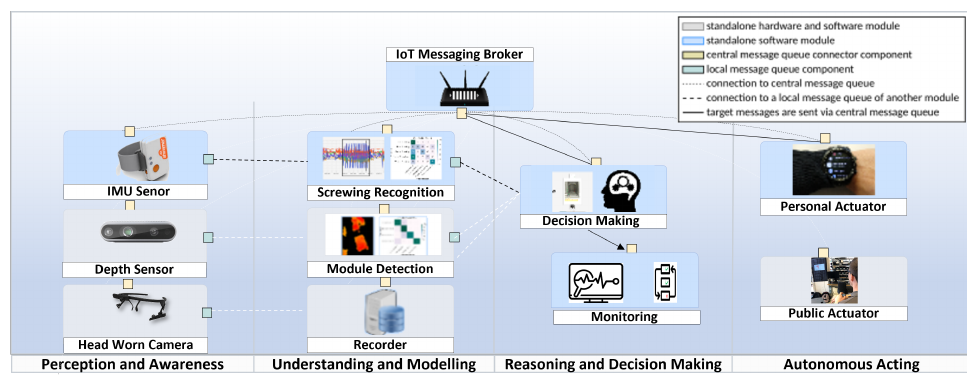
Figure 4. Sensory and actuatory interaction via IoT messaging